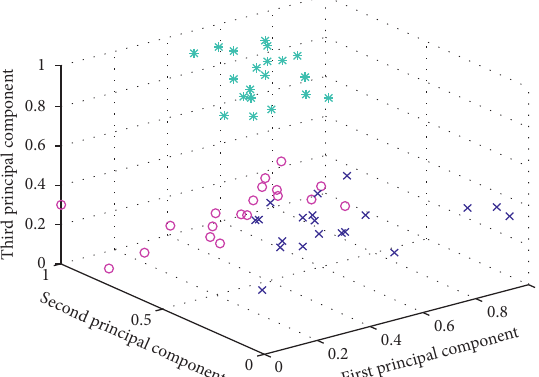
Figure 11: Recognition rate (91.67%) of test data.